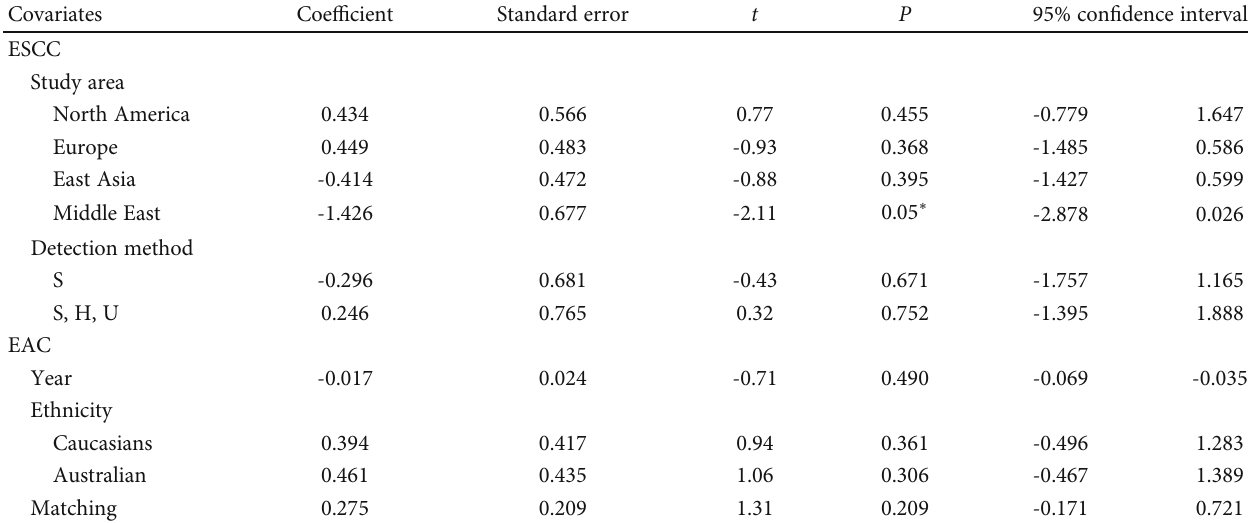
Table 5: Multivariate metaregression analysis for the potential variables between